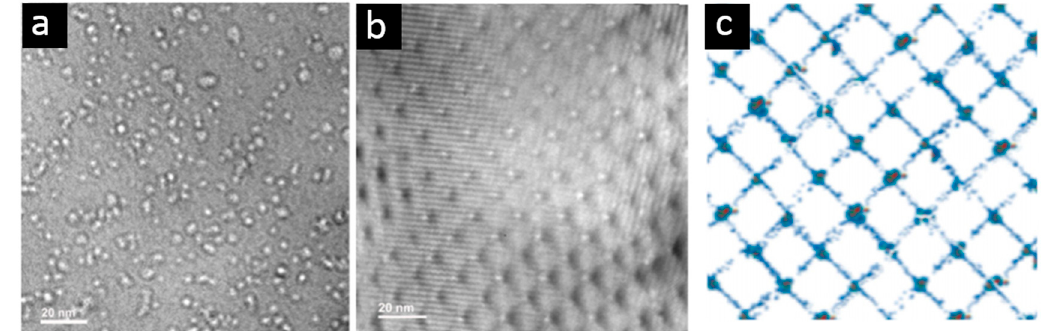
Figure 12. ( a ) Dense He bubbles in single-crystal Au after He irradiation; ( b ) He bubbles distribute on MDIs in a (001) twist grain boundary with a misorientation angle about 1°; and ( c ) Metropolis Monte Carlo simulation shows dislocation network in blue and He bubble at MDIs in red. Reprinted with permission from [115]; Copyright 2012 Elsevier.